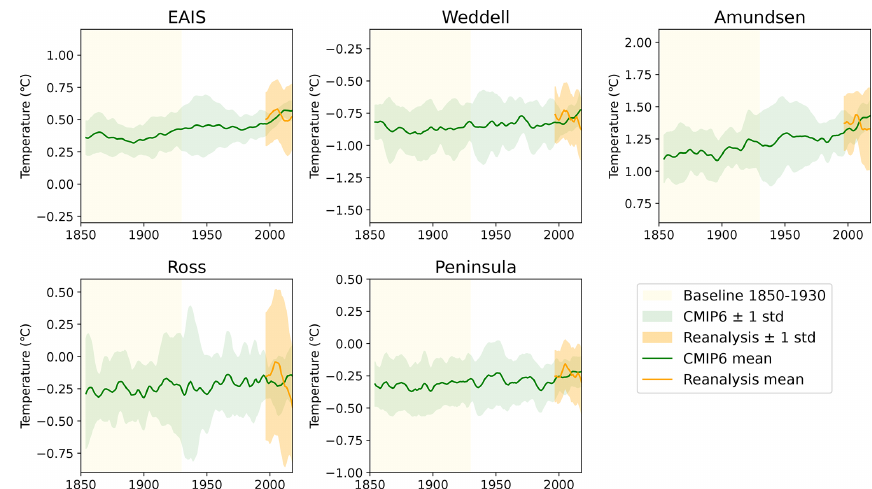
Figure 3. Annual mean subsurface ocean temperature time series averaged over all ESMs (green), model drift-adjusted and bias-adjusted, and the GREP ensemble mean (orange). Both are smoothed by a 5-year running average filter. The temperature is derived from a 100m thick layer centred around the mean depth of the ice shelf base as specified in Table 2. The historical experiment (1850–2014) is combined with SSP2-4.5 (2015–2018) for this visualisation. Note that the tick spacing of the vertical axis is the same for all regions but the ranges are different. Table 3. Overview of basal melt computation and calibration methods applied in this study. Two different depths were used for the thermal forcing: centred around the mean depth of the ice shelf base (Table 2) and the layer at 800–1000m depth. Also, two different basal melt parameterisation methods were employed: linear and quadratic. Each parameterisation has been calibrated Antarctic-wide and regionally on the Amundsen Region. Finally, median basal melt sensitivities used in LARMIP-2 (11.5myr − 1 K − 1 ) and ISMIP6 AntMean method (2.6myr − 1 K − 2 ) have been applied in the linear and quadratic parameterisation,